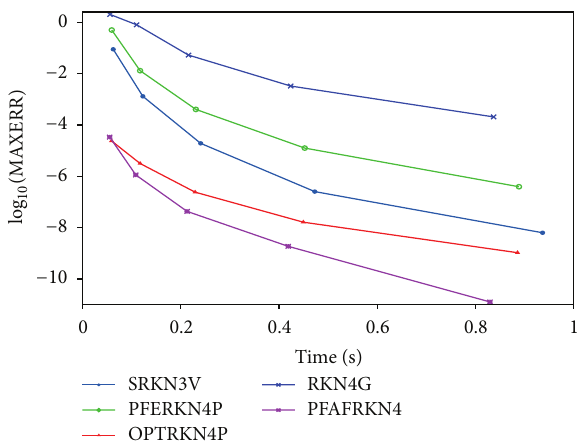
Figure 9: Efficiency curves for all methods for Problem 1 with 𝑒 = 0 and ℎ = 1/2 𝑖 , 𝑖 = 3, ...,7 .